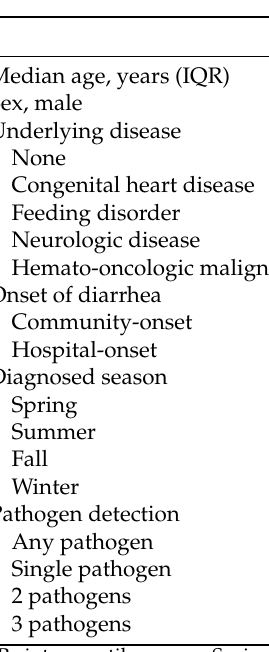
Table 1. Demographics and pathogen detection of patients in the prospective cohort.